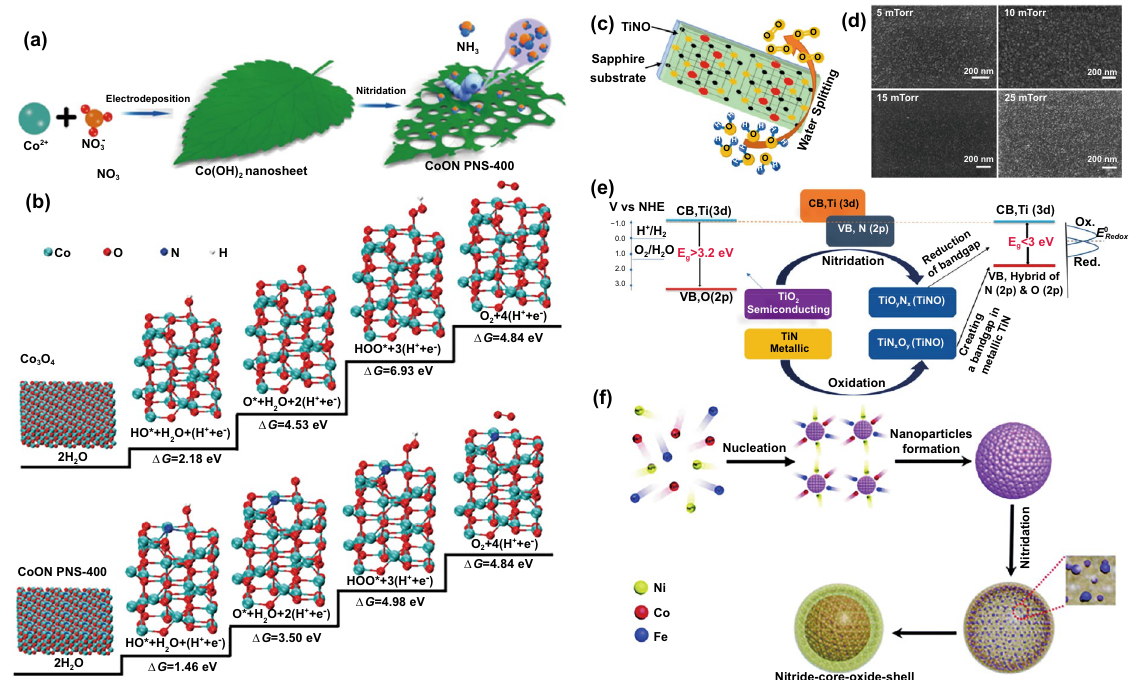
Fig. 3 a The schematic illustration of the formation of CoON PNS-400 nanosheets. b DFT calculated free energy diagram of the OER on Co 3 O 4 and b CoON PNS-400, respectively. Reprinted with permission from Ref. [84]. Copyright Year 2018, Wiley–VCH Verlag GmbH & Co. KGaA, Weinheim. c Schematic illustration of TiNO thin films for electrocatalytic water oxidation, d SEM images of TiNO films grown in oxygen pressures of 5, 10, 15, and 25 mTorr, e Band diagram showing a downward movement of VB via nitridation of TiO 2 and opening of a bandgap between overlapping valence and conduction band in a metallic TiN via oxidation of TiN. Reprinted with permission from Ref.